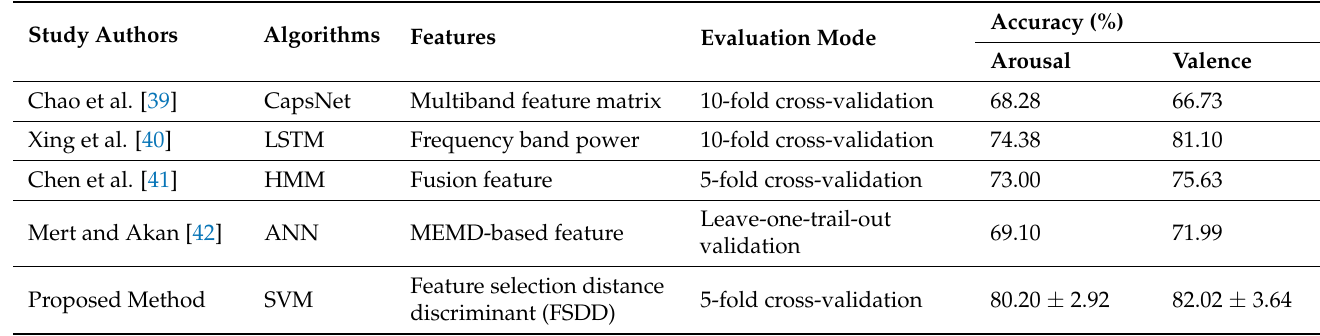
Table 5. Comparative analysis of current work with other existing related studies.